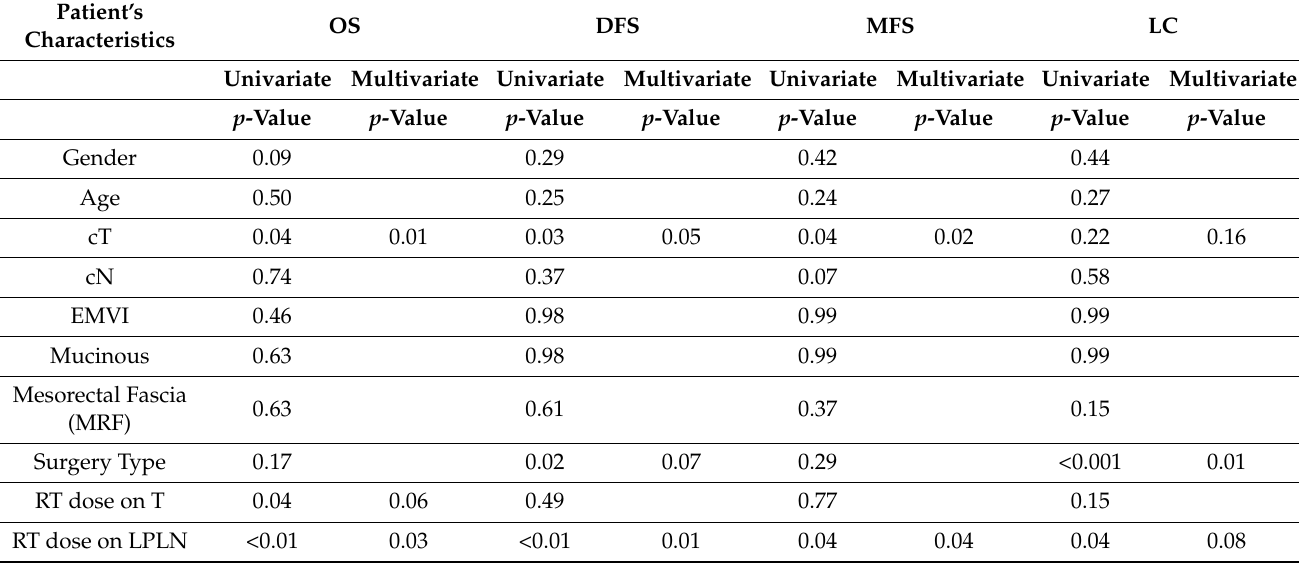
Figure 7. Local control (LC). Univariate and multivariate analysis results are depicted in Table 3.